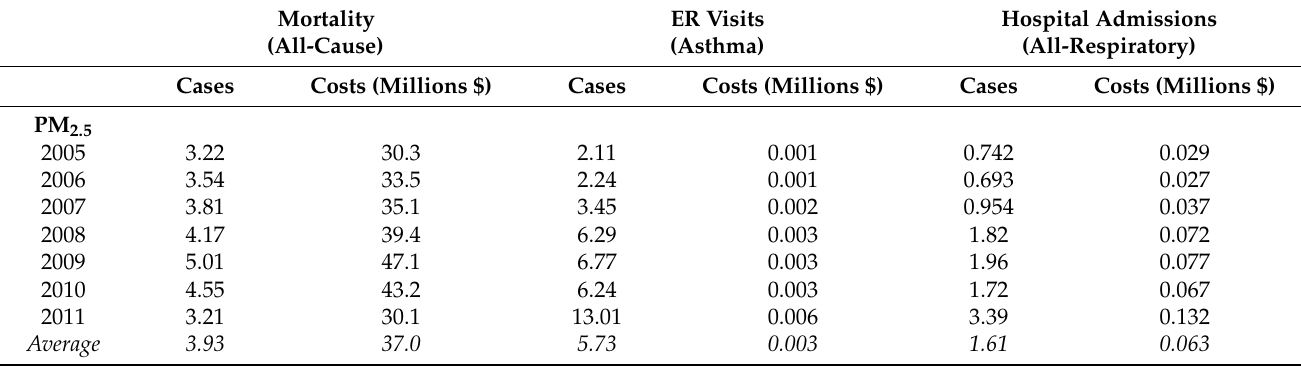
ER Visits Hospital Admissions (Asthma) (All-Respiratory)